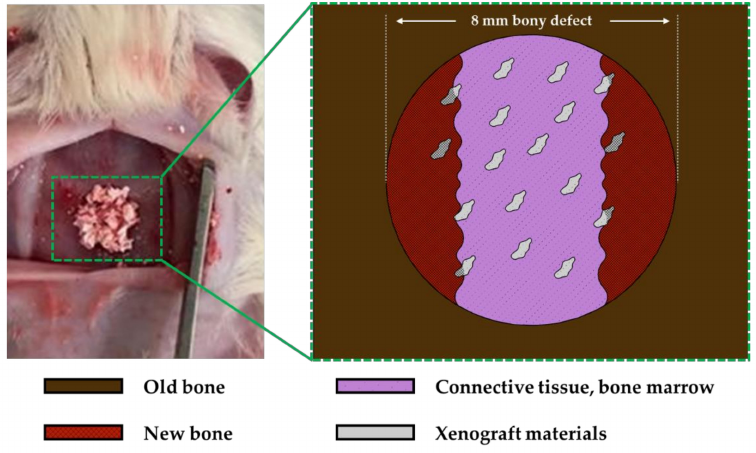
Figure 3. Schematic drawing of animal model for histometric